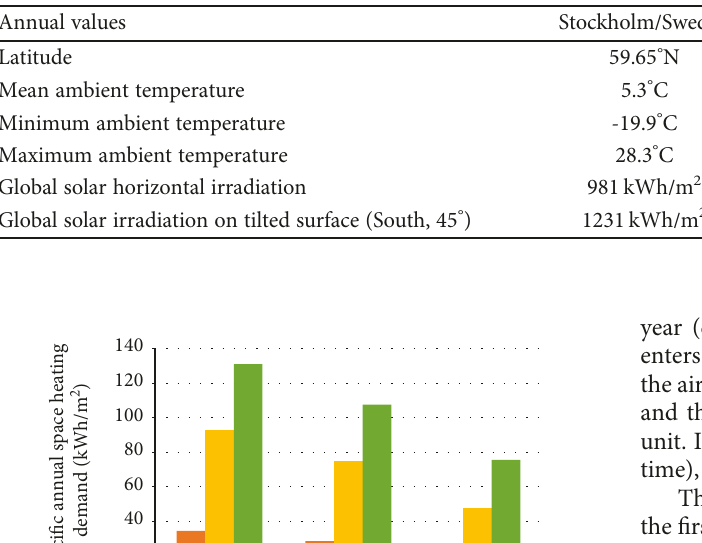
Table 3: Climatic conditions of considered sites.